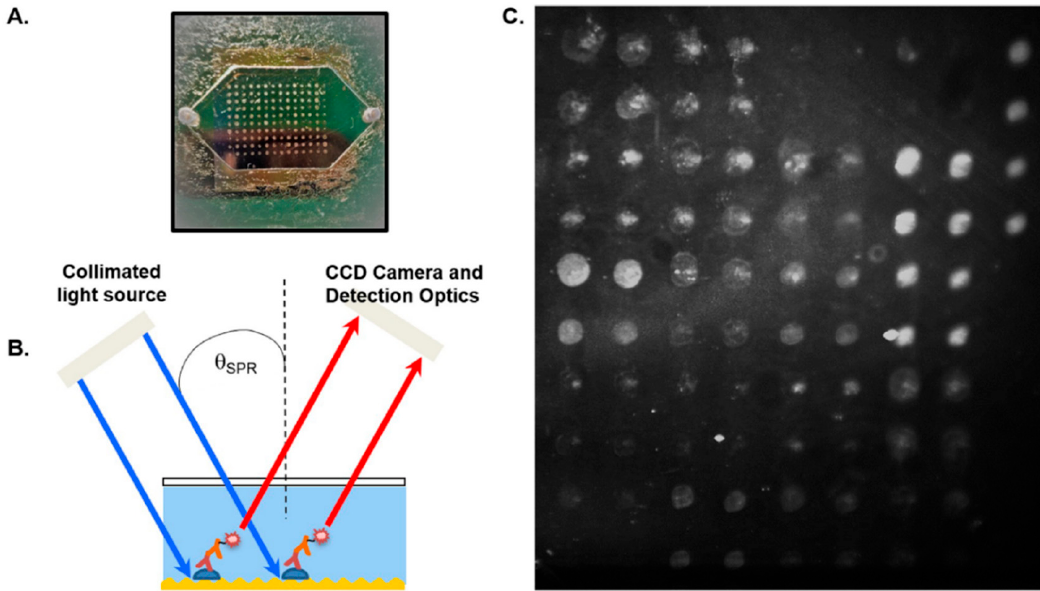
Figure 4. Microfluidic protein biochip showing ( A ) biochip device with overlying microfluidic window ( B ) illustration of antigen-antibody binding process with Surface Plasmon Resonance (SPR)-enhanced fluorescence ( C ) fluorescent image of an antibody-bound biochip. Reprinted from ref [47], which is open access under the Creative Commons Attribution 4.0 International license.